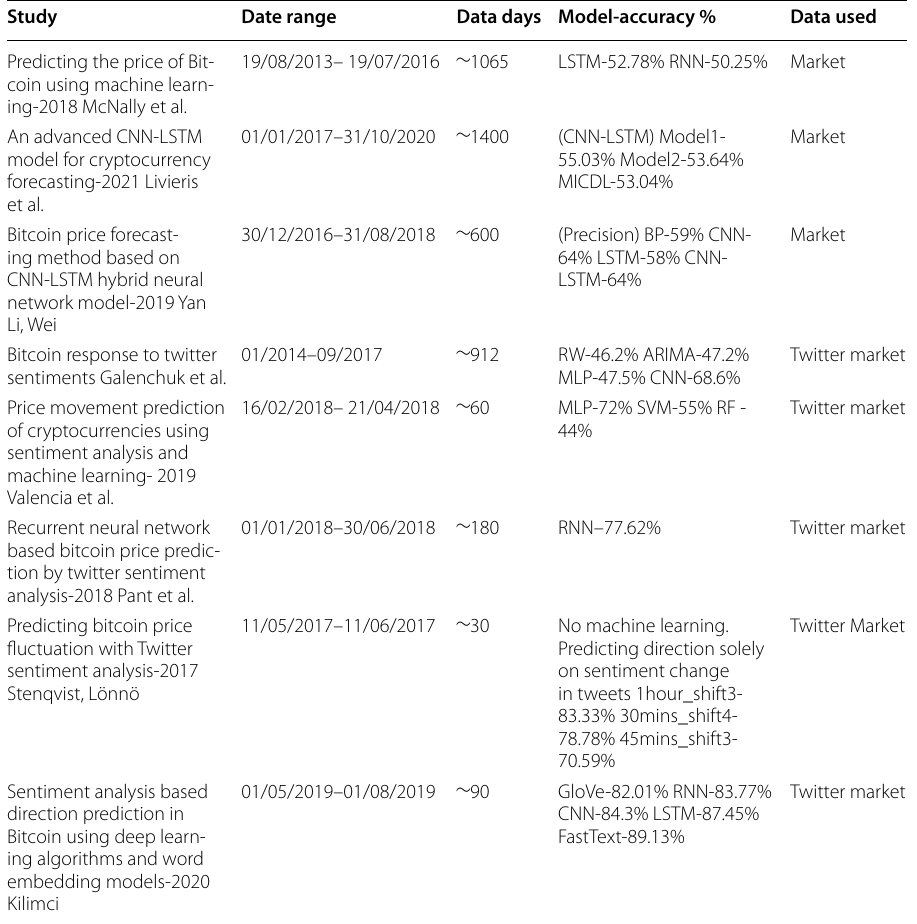
Table 1 Existing studies and models Study Date range Data days Model-accuracy % Data used Predicting the price of Bit- 19/08/2013– 19/07/2016 ∼ 1065 LSTM-52.78% RNN-50.25% coin using machine learn- ing-2018 McNally et al.